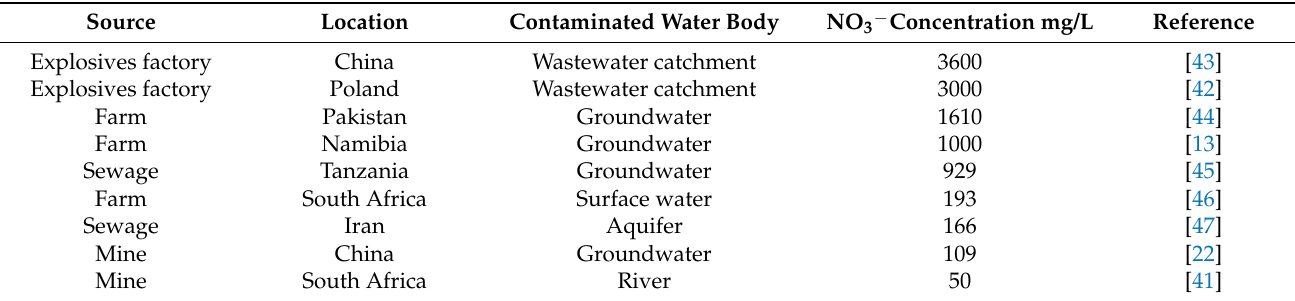
Table 1. Sources of anthropogenic nitrate